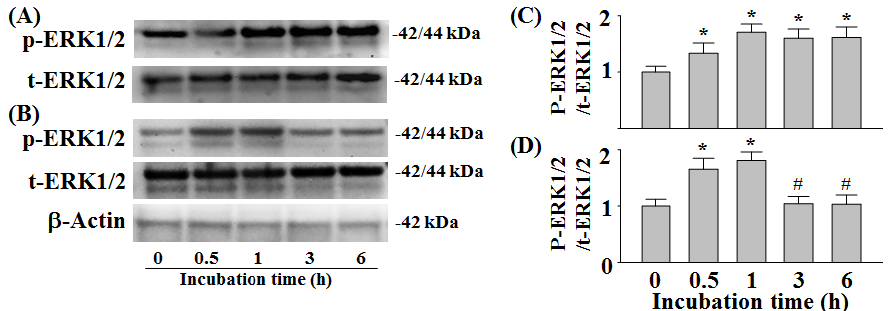
Figure 3. Effect of HTHQ on L -DOPA-induced ERK1/2 phosphorylation in PC12 cells. PC12 cells were exposed to 200 µM L -DOPA ( A , C ) in the presence of 10 µM HTHQ ( B , D ) for 0.5 – 6 h. The values of the relative density ratios of ERK1/2 phosphorylation (p-ERK1/2) to total ERK1/2 (t-ERK1/2) are expressed in arbitrary units. The results are expressed as the mean ± S.E.M. (n = 4). * p < 0.05 compared to control level (0 h), # p < 0.05 compared to values at 0.5 and 1 h (ANOVA with post-hoc Tukey’s test).